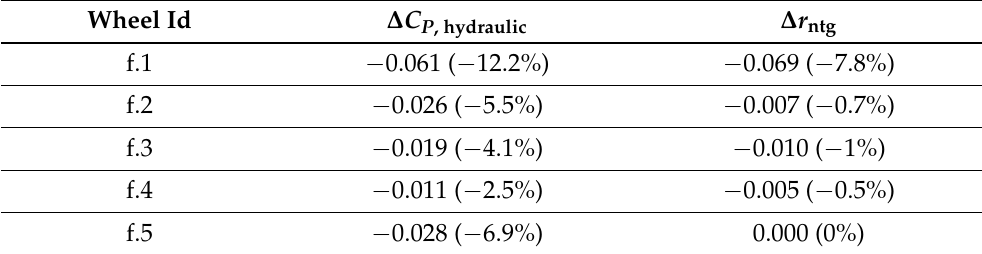
Figure 8. Performance of the top-five designs (Pareto front) evaluated once with a standard duration of physical time (15s, as with all individuals during the optimisation) and once with thorougher criteria (as detailed in the text). The relative change in performance for all five configurations is detailed in Table 4. Table 4. Change in the performance (value of objective functions) of the five top-performing individ- uals after a detailed evaluation was